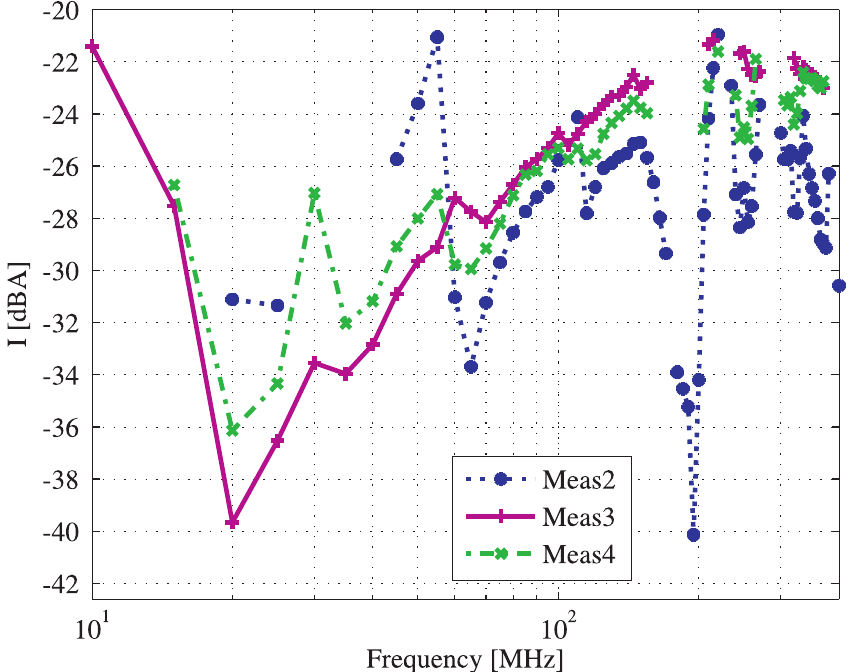
Figure 9. BCI immunity measurement for different caps presence in layout in Figure 2: Meas2 = C +